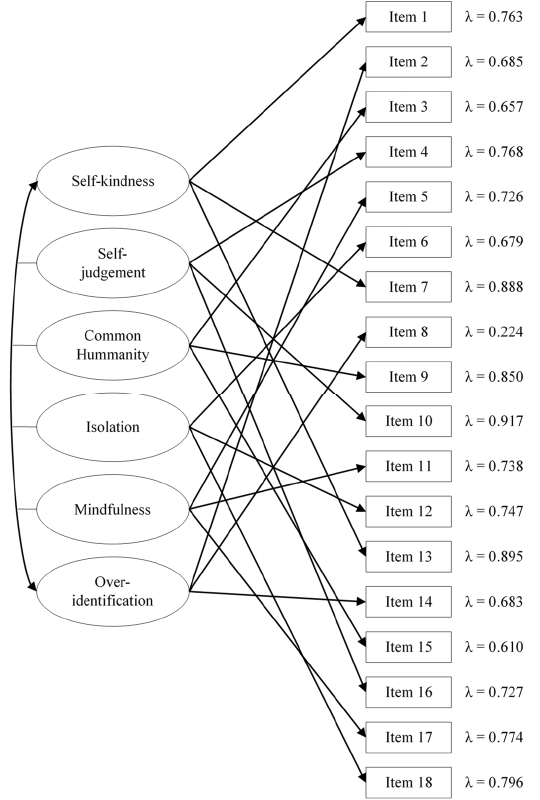
Figure 2. Analytical fit of the best fitting model for the SSCS–L. Notes: All factor loadings resulted statistically significant ( p < 0.001). For the sake of clarity, standard errors are not shown. Table 2. Sample